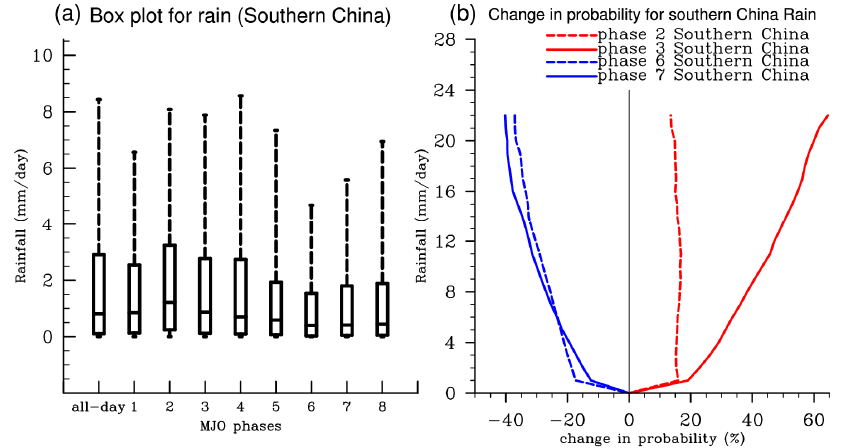
Figure 3. ( a ) PDFs of rainfall in southern China for the MJO phases 1–8 and all days (NDJFM). ( b ) Percentage change in the probability of rainfall for typical dry phases (red lines) and typical wet phases (blue lines) of MJO with respect to the PDF of all days.